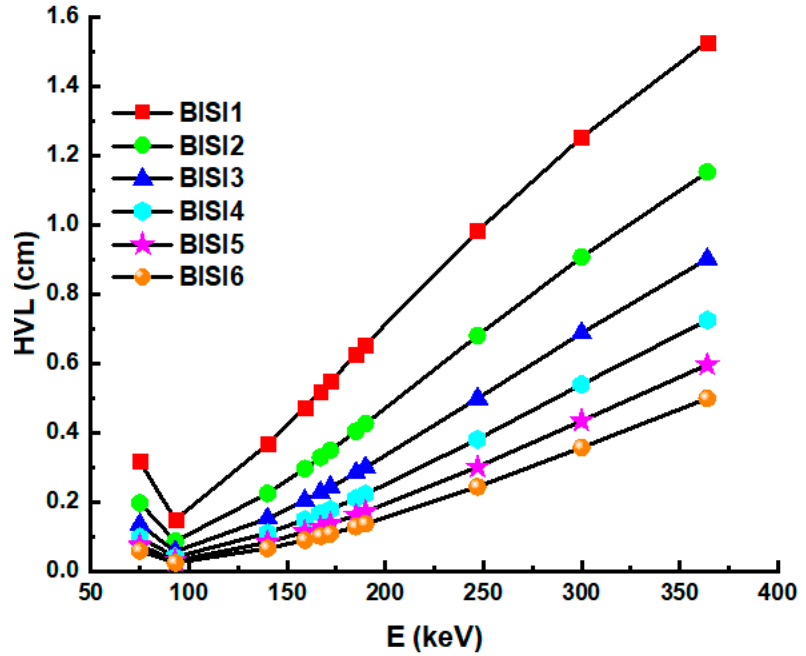
Figure 4. Half value layer (HVL) values as a function of photon energy of glass